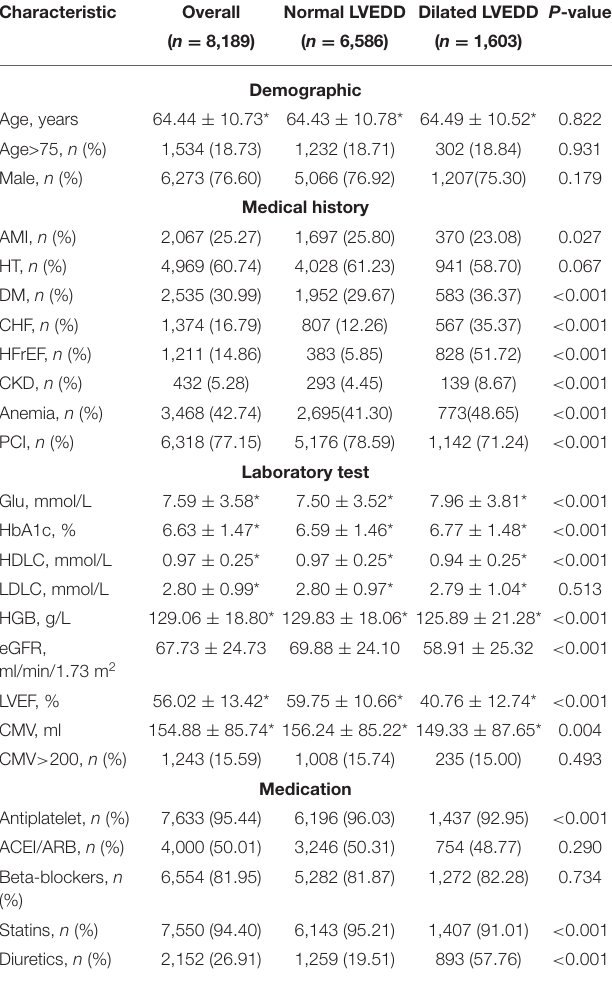
TABLE 1 | Baseline characteristics of the patients. TABLE 2 | Contrast-associated acute kidney injury (CA-AKI) incidence and clinical